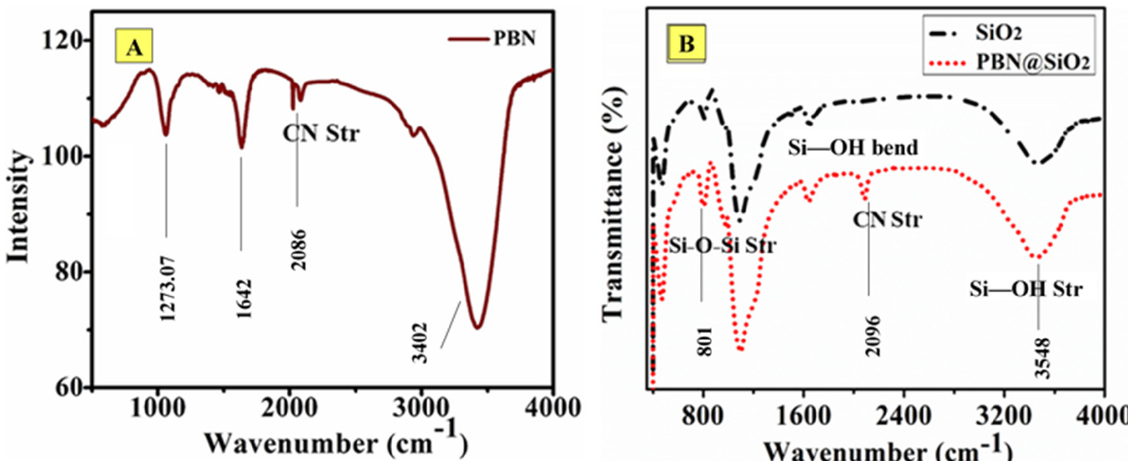
Figure 4. ( A ) FTIR spectrum of as-synthesized PBN; ( B ) FTIR spectra of (black line) SiO 2 and (red line) as-synthesized PBN@SiO 2 .